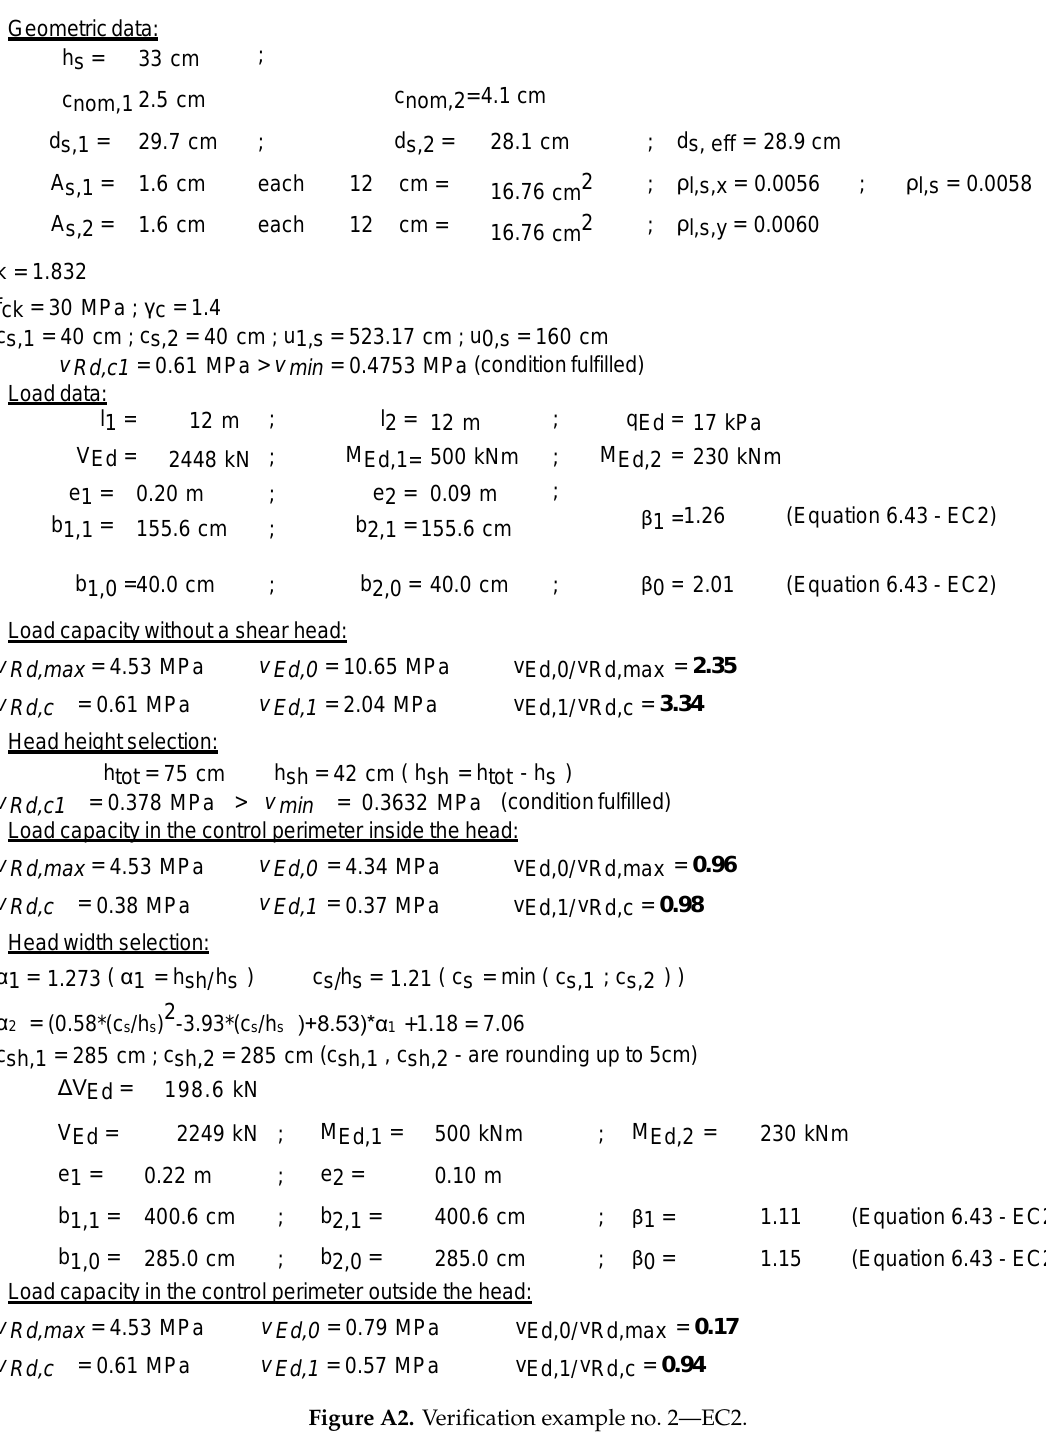
Figure A2. Verification example no. 2—EC2.